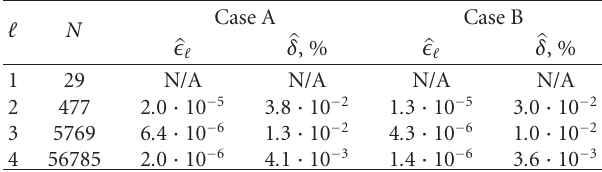
Table 6: Maximal error for the sparse grid